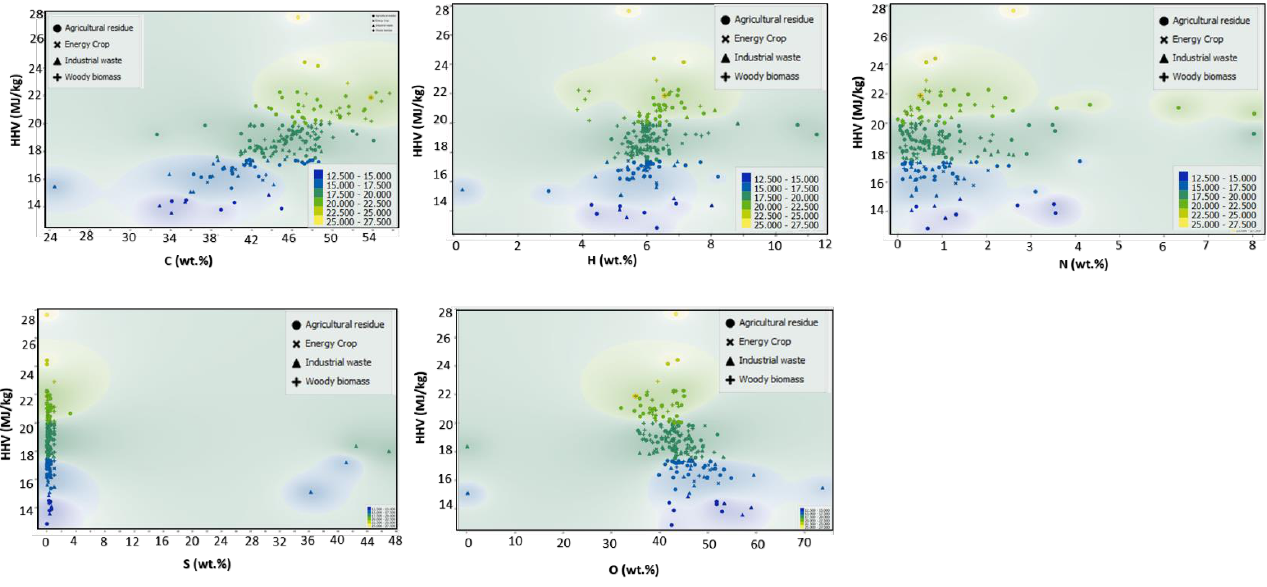
Figure 5. Cross-plots of HHV against the ultimate analysis of different biomass classes.